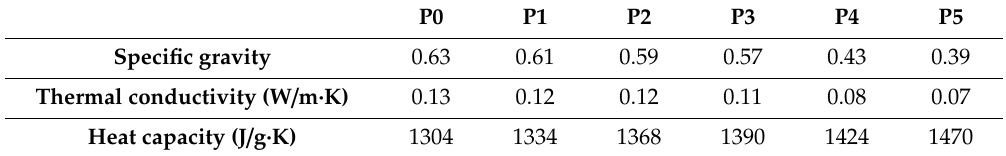
Table 7. Average thermal properties and density of WCAP as a function of the WA